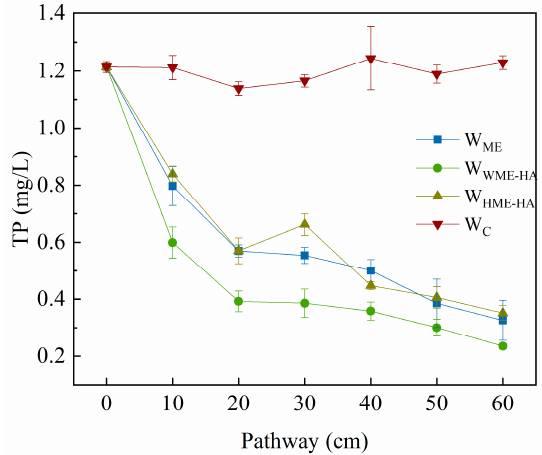
Figure 4. The concentration distribution of phosphorus over different heights in four SSFCWs.